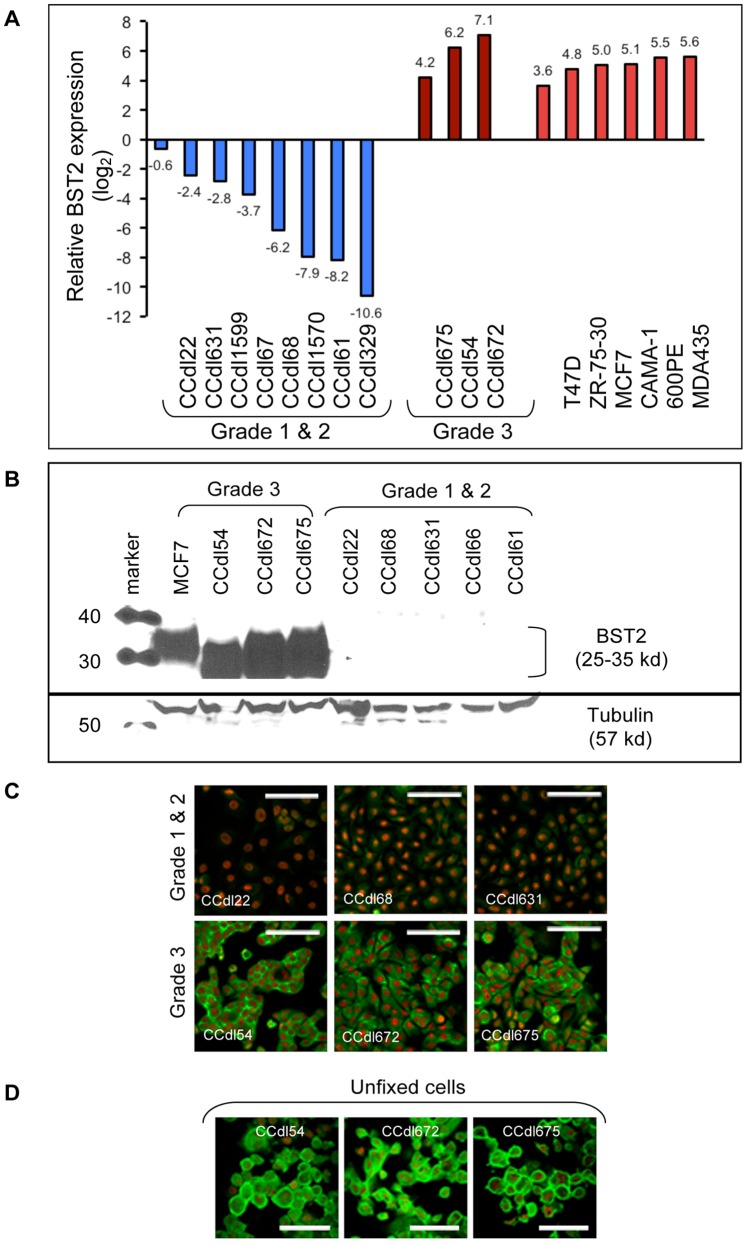
Differential BST2 expression in primary breast cancer of varying histological grade is maintained in tumor-derived cell lines.
A
. QPCR based BST2 transcript levels in 17 breast cancer cell lines normalized to expression in non-malignant breast epithelium. B. Western blot analysis of BST2 protein (25–35 kd) in breast cancer cells. Tubulin used as a loading control. C. Microscopic images of BST2 immunostaining (green) in fixed, permeabilized breast cancer cells. Nuclei counterstained with propidium iodide (red). Bar –50 µm. D. BST2 immunolocalized at the cell membrane in live, unfixed breast cancer cells. Bar –25 µm.